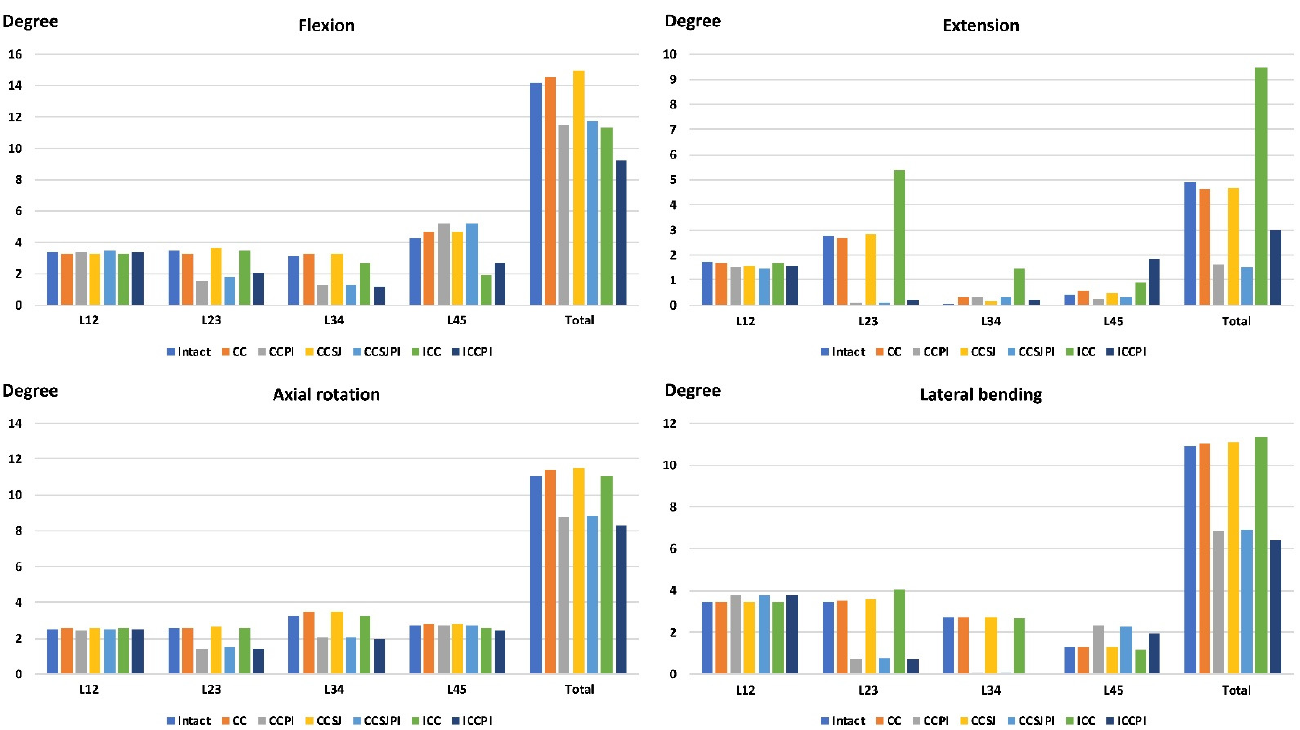
Figure 6. The results of ROMs.